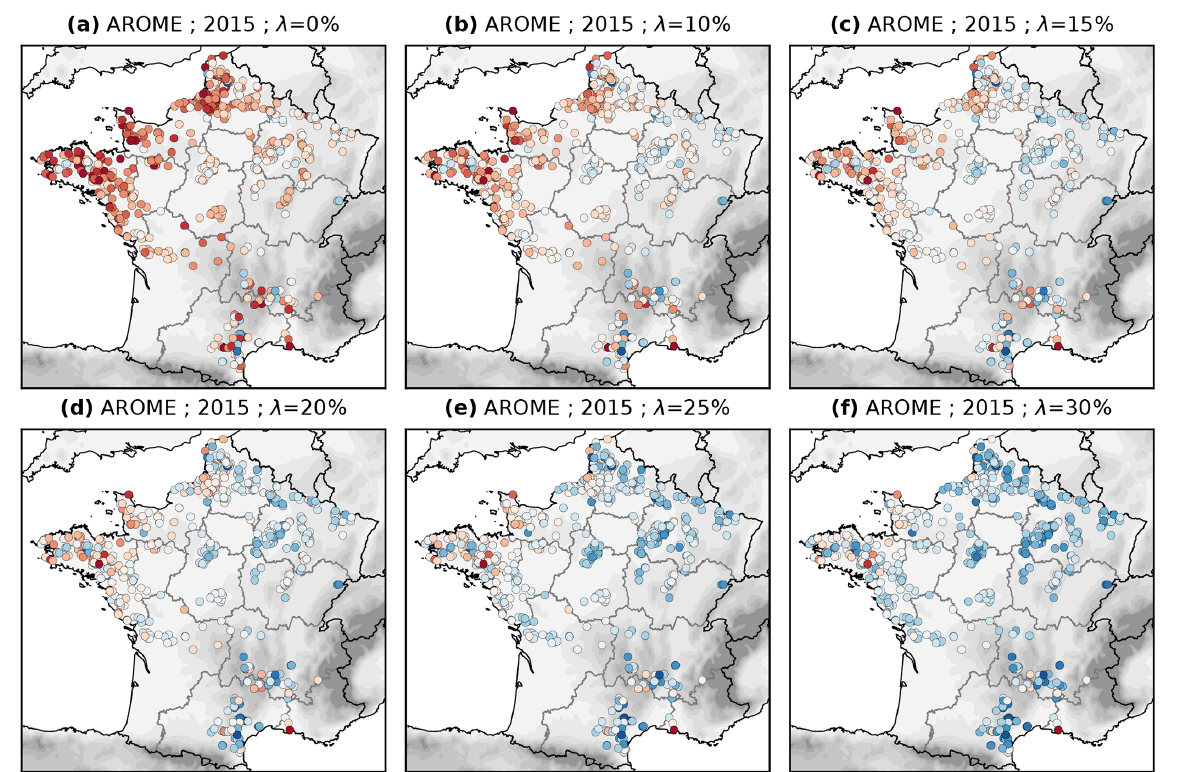
Figure 6. Local biases of wind-power production simulations based on AROME for year 2015 for loss factors varying from 0% to 30%. Same scale as Fig.